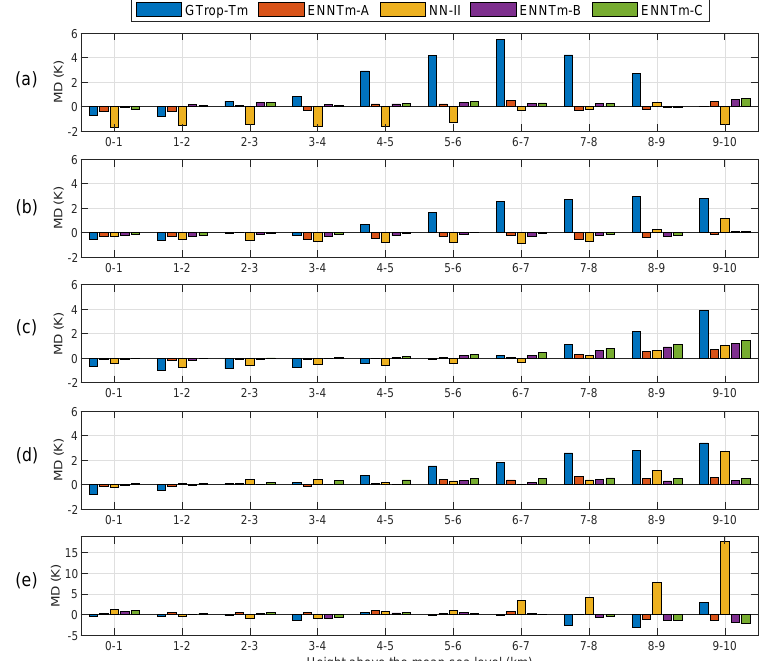
Figure 11. The statistics of MDs at different height layers in the ( a ) NFZ; ( b ) NTZ; ( c ) TZ; ( d ) STZ; and ( e ) SFZ.